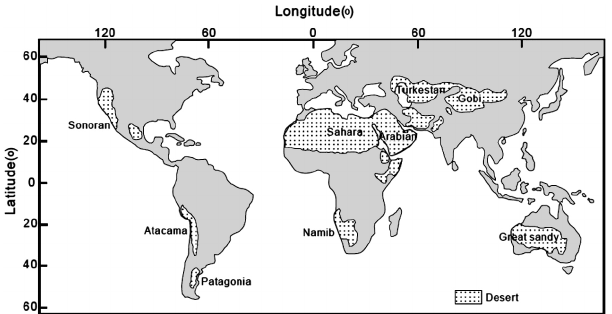
Figure 21. Distribution of world major deserts (modified after Meigs,